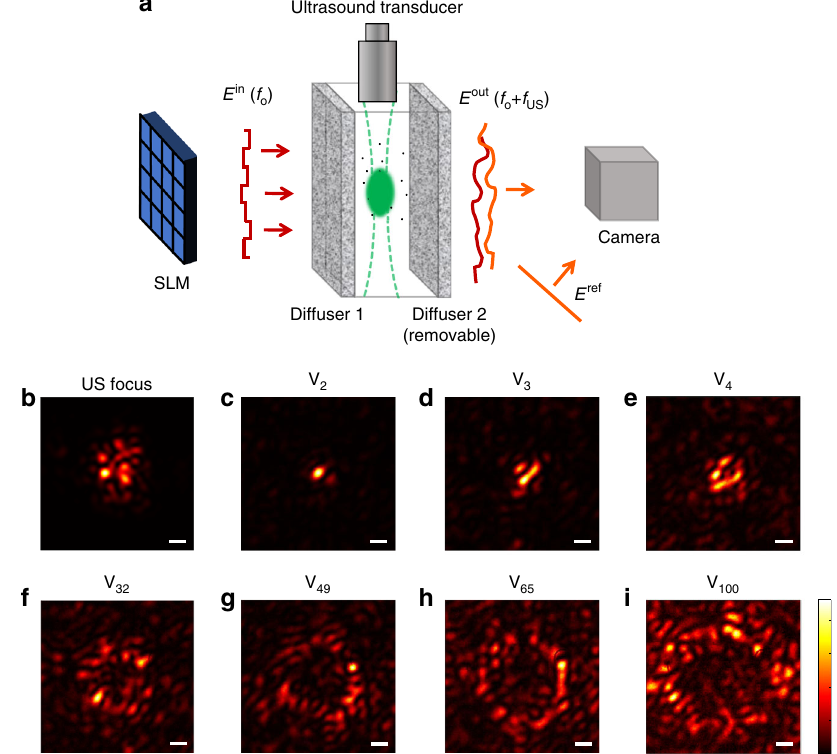
Fig. 2 Focusing using singular value decomposition of an acousto-optic transmission matrix. a Experimental setup. b – i measured optical intensity distributions at the ultrasound focal plane: b optical intensity of the ultrasonically tagged optical fi eld for a plane wave input, displaying the dimensions of the ultrasound focus. c – i optical intensity distributions measured when injecting the 2 nd , 3 rd , 4 th , 32 nd , 49 th , 65 th , and 100 th singular vectors of the acousto- optic transmissiom matrix (AOTM). While the fi rst singular vectors focus light at a sharp focus smaller than the ultrasound focus, with peak to background ratio (PBR) of 290, 175 and 94 for c , d , and e respectively, singular vectors with lower singular values result in concentric rings around the ultrasound focus center with increasing diameter. scale-bars, 67 μ